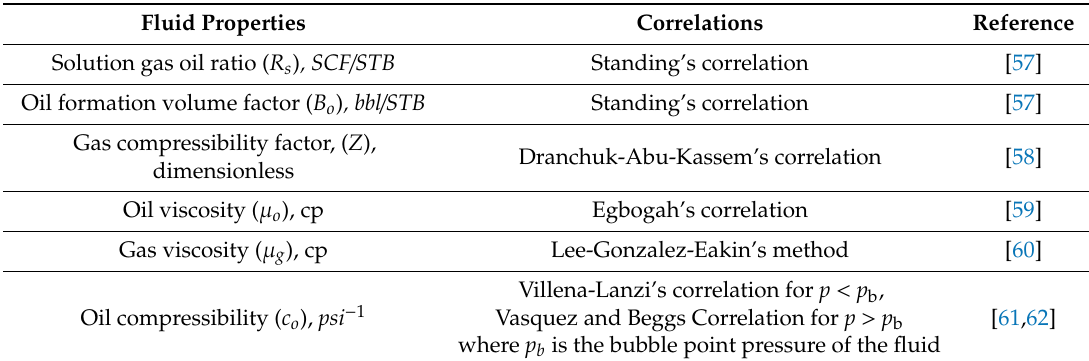
Table 4. Summary of PVT